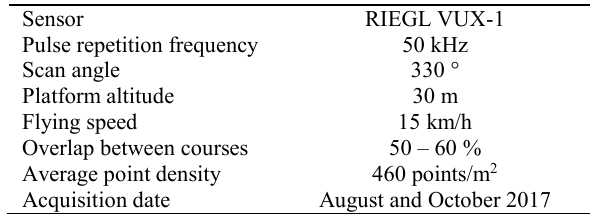
Table 1. Specifications for the LiDAR data acquisition